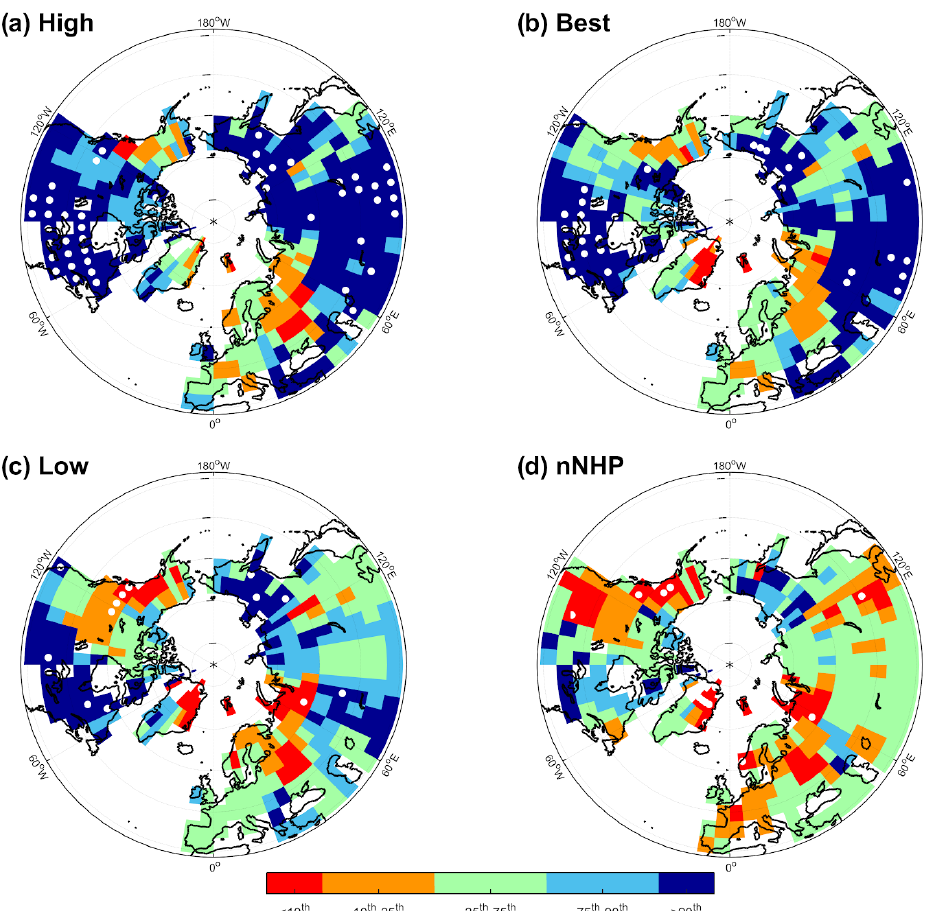
Figure 10. Spatial comparison of NH extratropical land temperatures for summer 1810. Statistical comparison of reconstructed surface summer temperatures from N-TREND (S) (Anchukaitis et al., 2017) with the ensemble distributions of the four MPI-ESM ensembles (10 members). Anomalies are for the year 1810 with respect to the 1800–1808 mean. The shading shows, for each grid point, the percentile range of the ensemble simulation in which the reconstructed temperature falls. Green patches indicate that the reconstruction lies in the interquartile range of the simulations and is hence in good agreement with the ensemble. Bluish patches indicate that the reconstruction lies in the higher range of the ensemble; i.e., the majority of simulations are colder than the reconstructions. Reddish patches indicate that the reconstruction lies in the lower range of the ensemble; i.e., the majority of simulations are warmer than the reconstructions. White dots indicate where the reconstruction is an outlier with respect to the distribution of the simulation ensembles, i.e., where the absolute difference between the reconstruction and simulation ensemble mean is greater than 3 times the median absolute deviation of the simulation